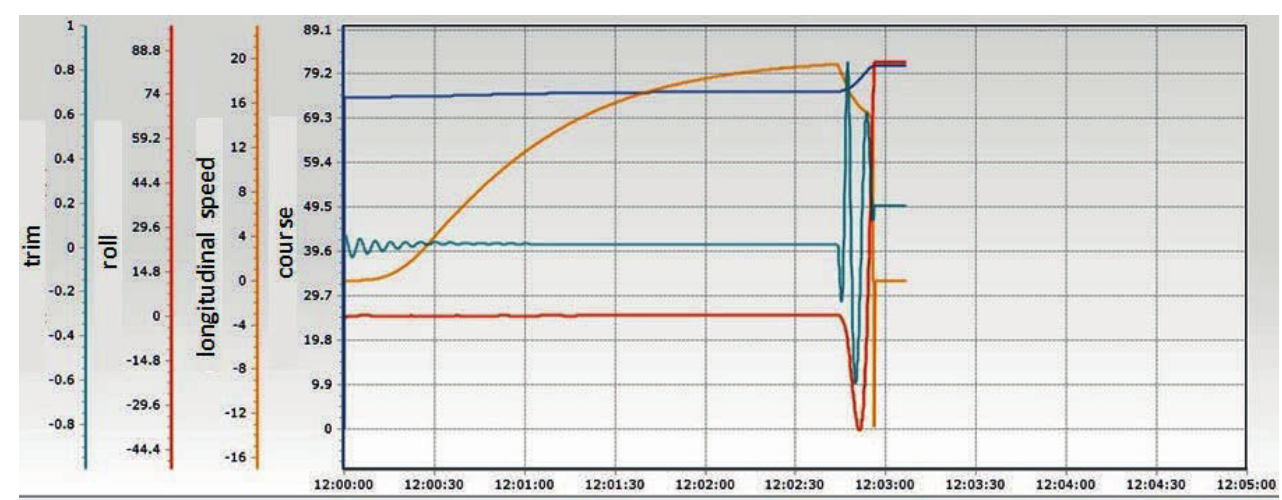
Fig. 6. Parameters of the Ro-Ro passenger ferry 13 movement by course